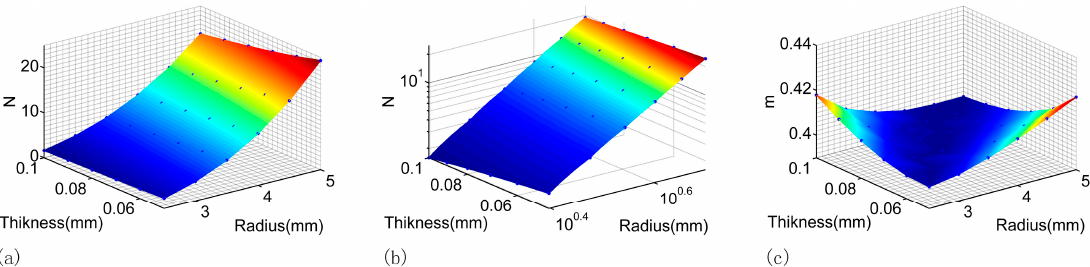
Figure 8. 2D surface plot of ( a ) the [ R , h ] → N relationship; ( b ) the [ R , h ] → m relationship in logarithmic scale and ( c ) [ R , h ] → m relationship. The dot in each plot represents one certain FEM calculated point in Table 1, and the surface in each plot represents the fitting function.